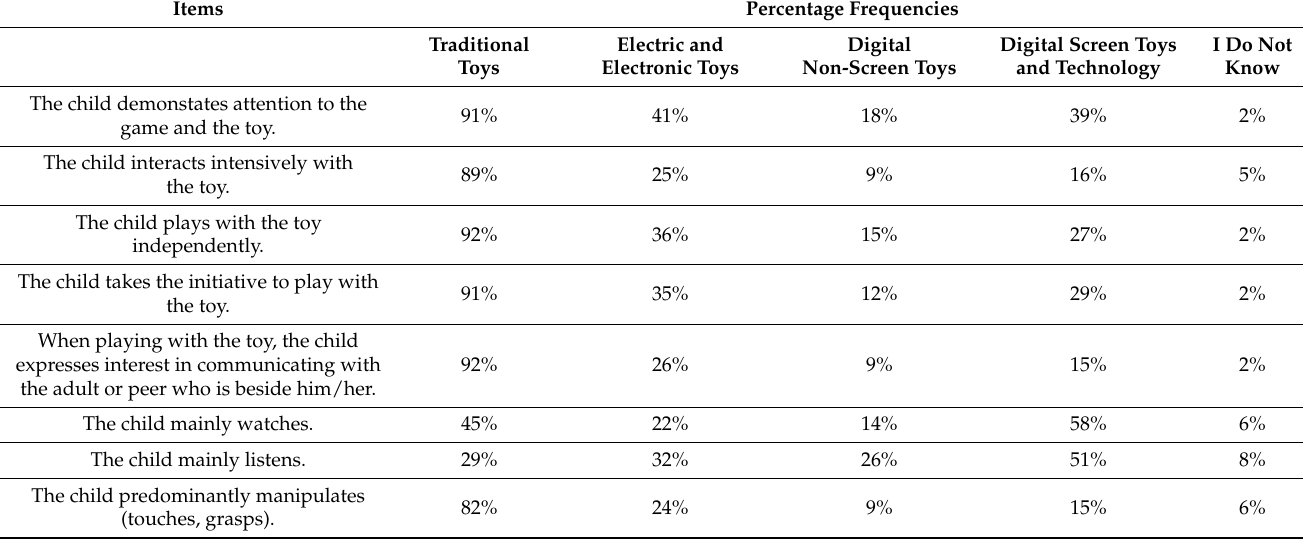
Table 4. Child’s engagement in play—analogue vs. digital.